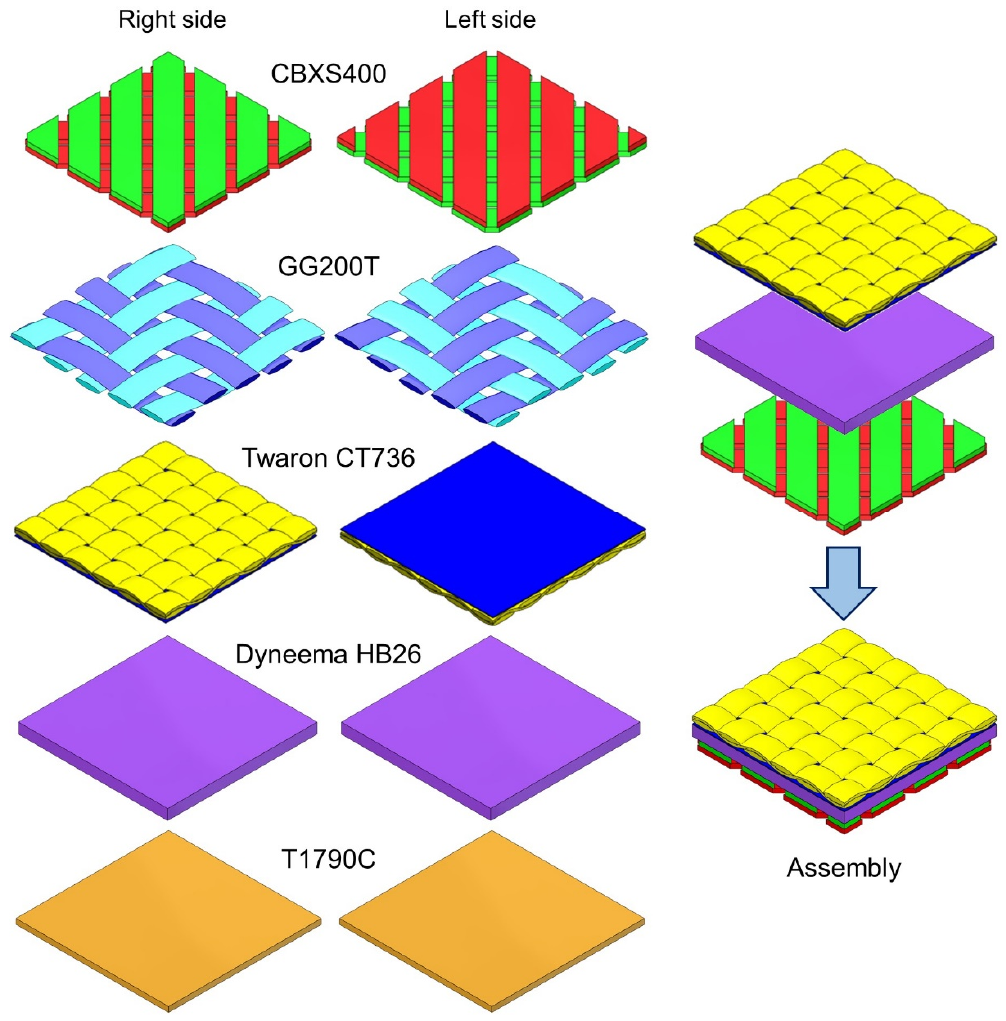
Figure 5. Both side view of 3D models of five tested textiles and assembly (surface area: 10 mm × 10